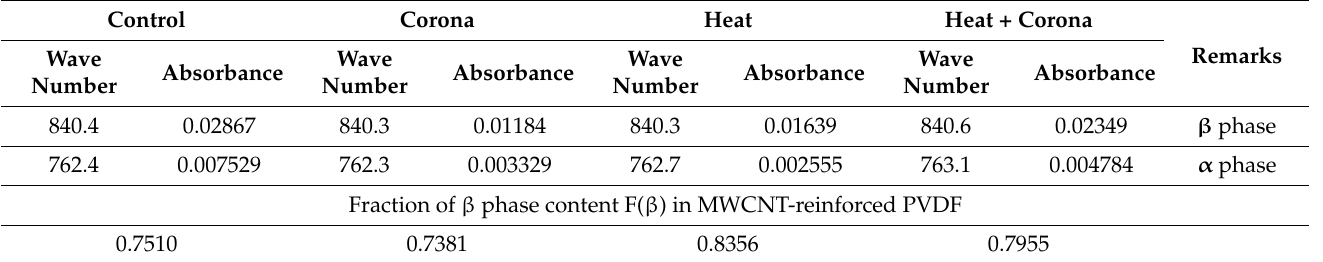
Table 3. FTIR results and fraction of β phase formation in MWCNT reinforced PVDF sample.